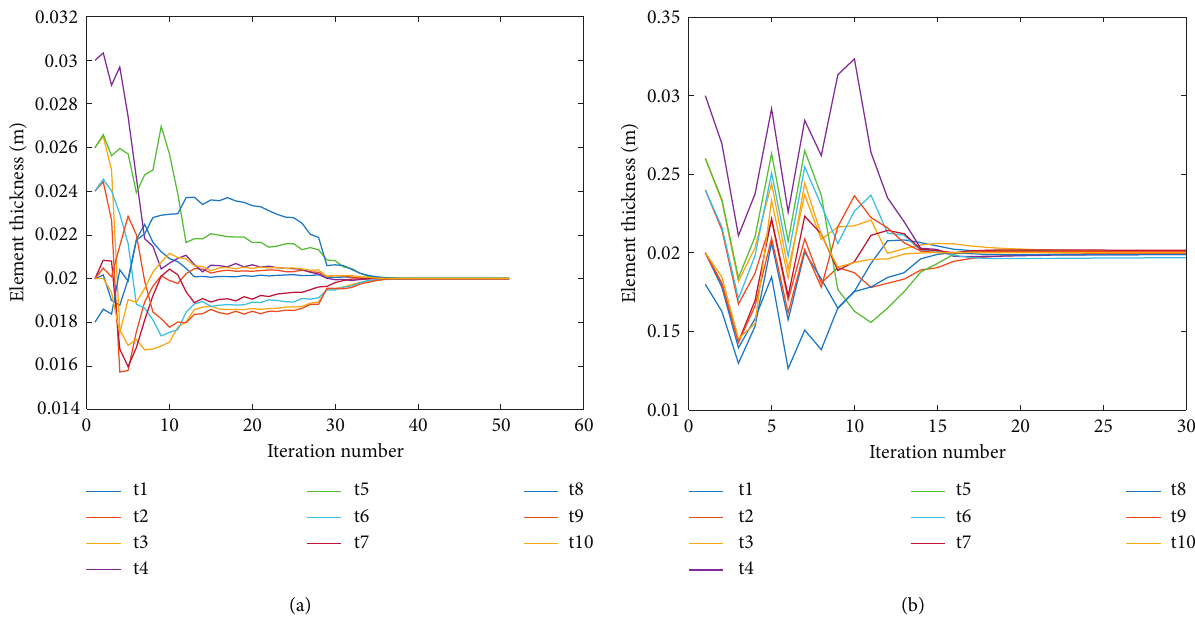
Figure 3: Convergence of the thicknesses of each element for case 1. (a) Proposed updating method; (b) updating with the Rayleigh damping model using the FRFs around the 1st and 3rd modes.